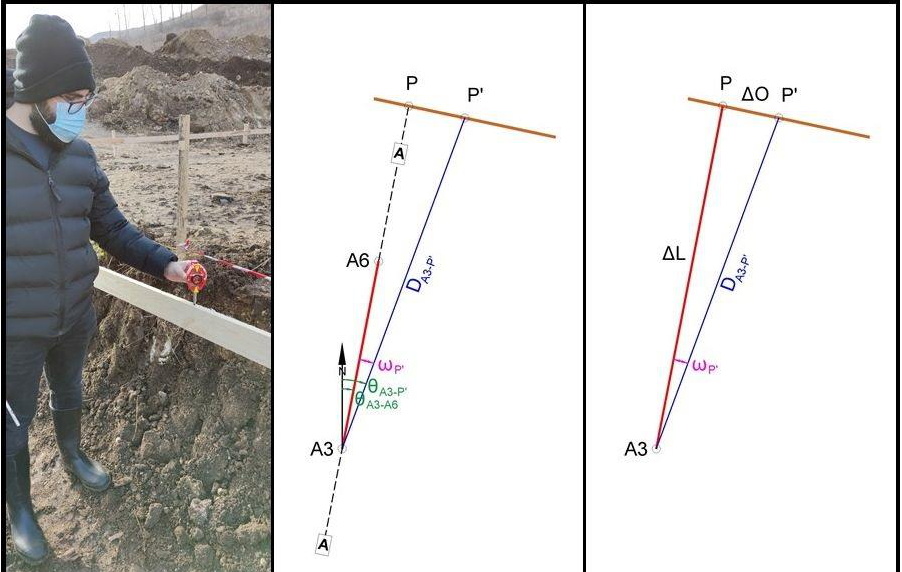
Figure 13. Reference line method applied on field ( left ) and general concept ( right ).